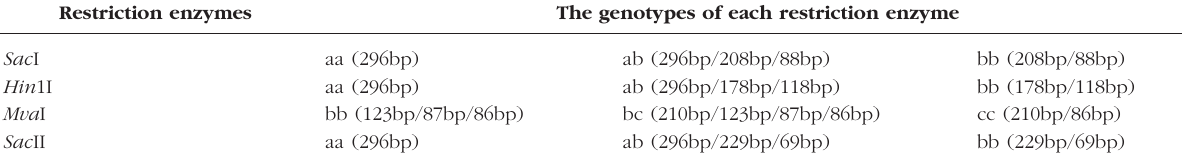
Table I. – PCR-RFLP genotypes of the second exon of the MHC- DRB 1 gene.